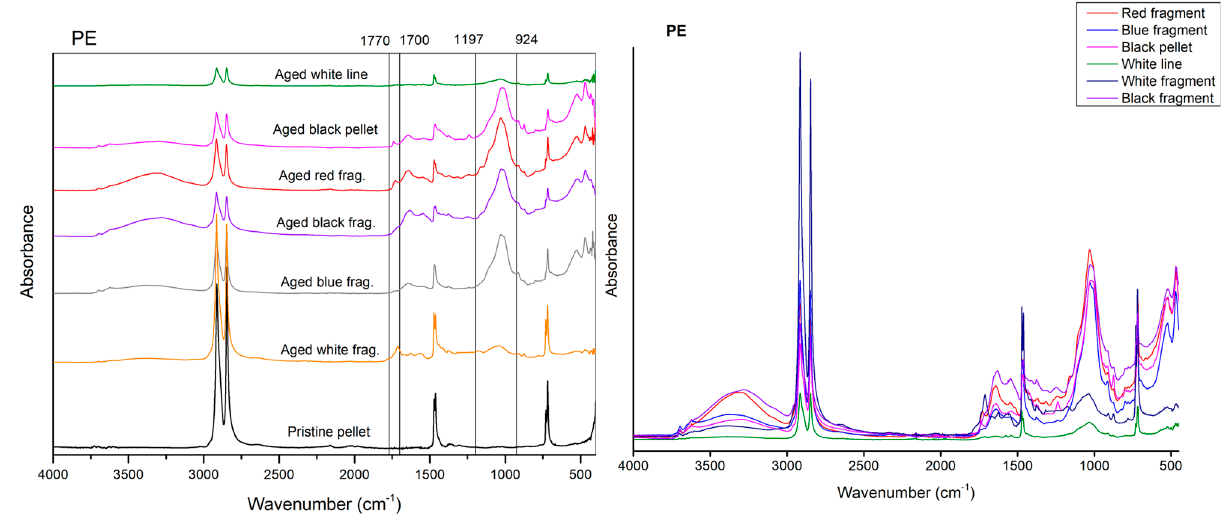
Figure 5. Comparison among the spectra of the PE natural weathered particles.